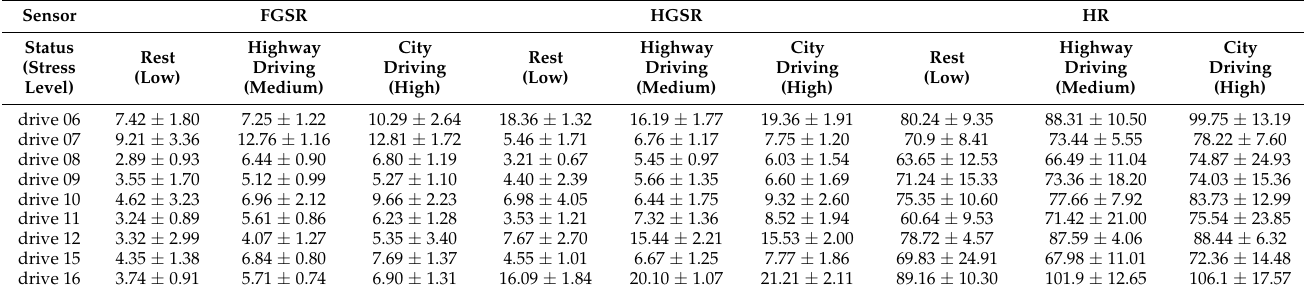
Table 3. Mean and standard deviation of the three physiological signals for 9 recordings used in experiment. Sensor FGSR HGSR HR Status Highway City Rest (Stress Driving (Low) Level) (Medium)